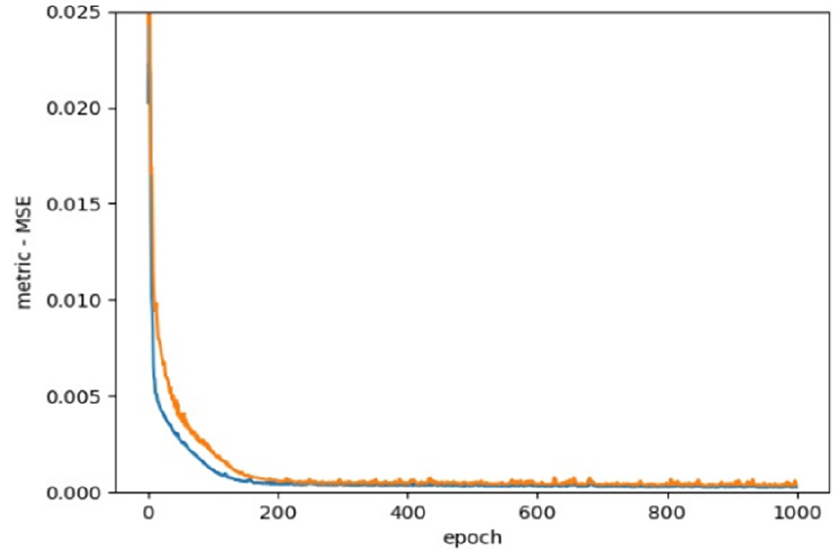
Figure 4. Loss function, MSE.